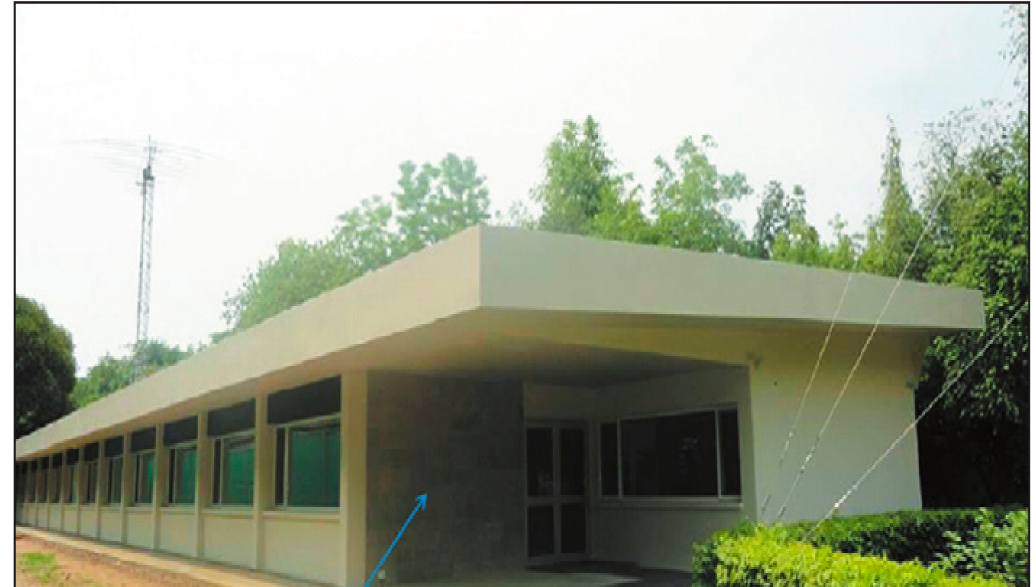
Figure 12. LC 3 AAC blocks used for office building in Swiss embassy, New Delhi [76].